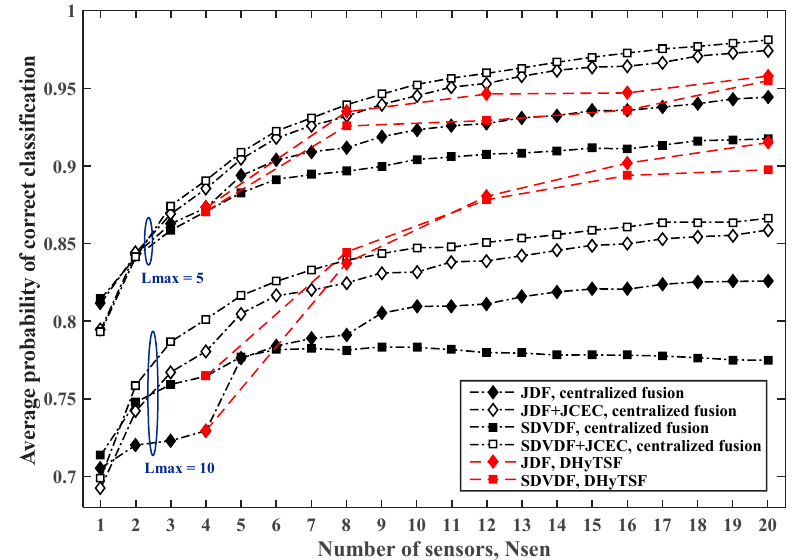
Figure 7. The estimated P CC , avg value for the centralized and distributed cooperative MC in SNS1, for N S = 2000 and di ff erent dispersive environments ( L max = 5 and L max = 10 ).